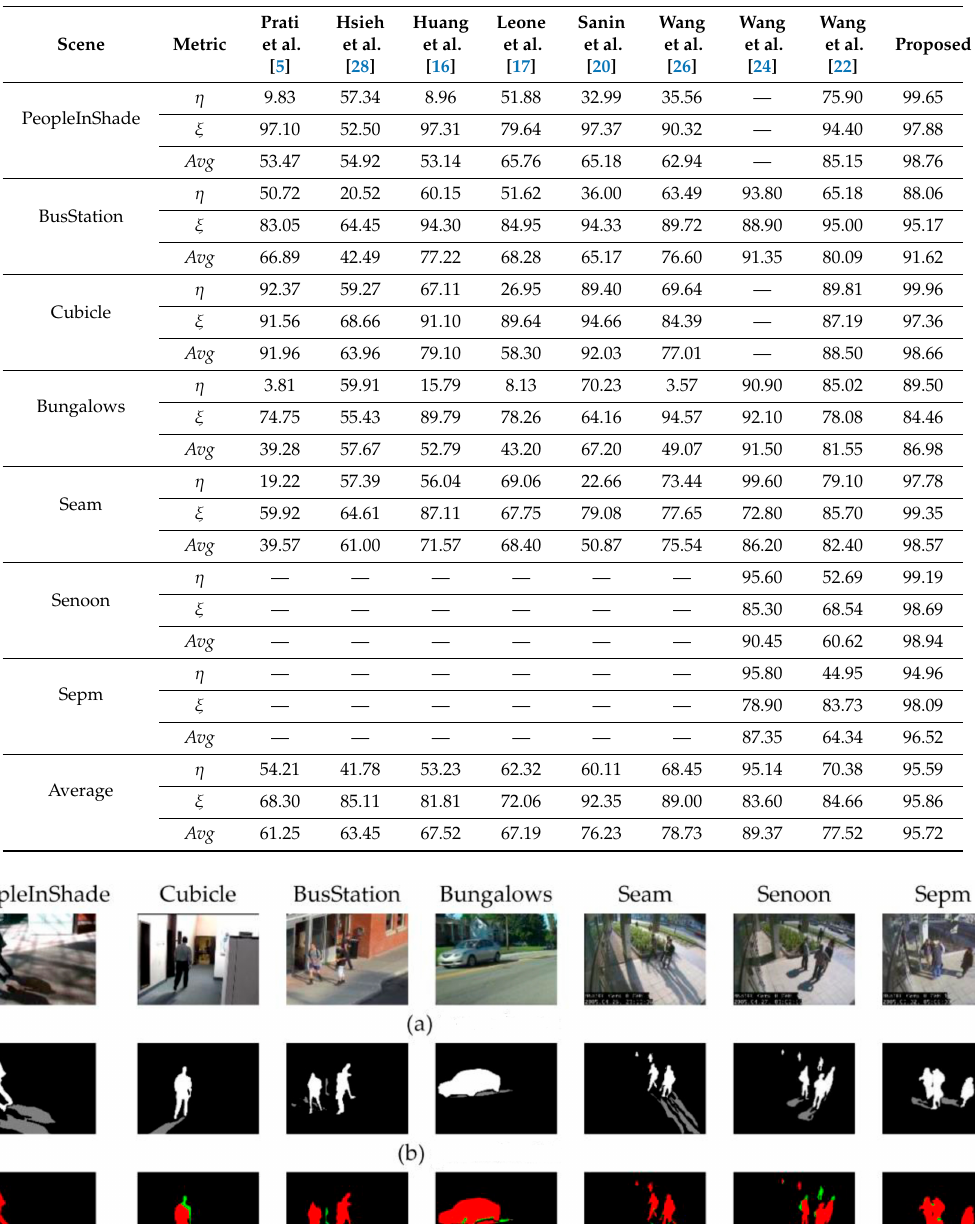
Table 4. Shadow detection results of the proposed method and compared methods on the large dataset.